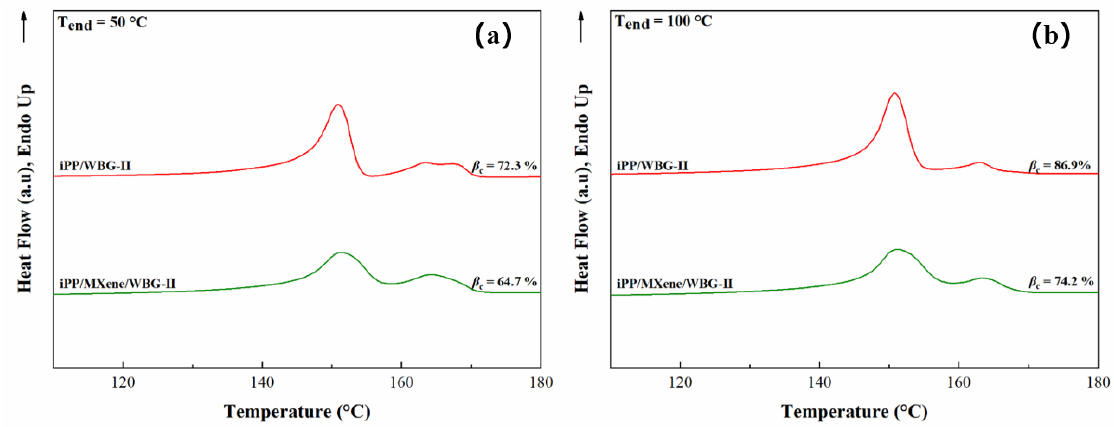
Figure 8. DSC heating curves of iPP/WBG-II and iPP/MXene/WBG-II at ( a ) T end = 50 °C and ( b ) T end = 100 °C.